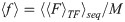
The free energy of nonconsensus TF-DNA binding positively correlates with the nucleosome occupancy.(a) The average free energy of nonconsensus TF-DNA binding per bp, 〈f〉=〈〈F〉TF〉seq/M (red), and the average nucleosome occupancy from [4] (gray), around the TSSs of 23,287 mRNA coding and non-coding C. elegans genes. The linear correlation coefficient is computed for a linear fit of 〈f〉 versus the average nucleosome occupancy at individual genomic locations, computed every 4 bp, within the interval (-1000,1000). In order to compute error bars, we divided genes into five randomly chosen subgroups, and computed 〈f〉 for each subgroup. The error bars are defined as one standard deviation of 〈f〉 between the subgroups. (b) Correlation between the minimal value of the free energy of nonconsensus TF-DNA binding, f
min = min(f), and the nucleosome occupancy, computed for individual genes in non-overlapping windows of 100 bp within the interval (-1000,1000) around the TSS for each of the 23,287 genes. The data was grouped into 50 bins. (c) Similar to (a) but showing the average free energy of nonconsensus TF-DNA binding per bp, 〈f〉 (red), and the average H2A.Z nucleosome occupancy (grey) around the TSSs of 12,188 D. melanogaster genes [32]. (d) Similar to (b) but for 12,188 D. melanogaster genes.